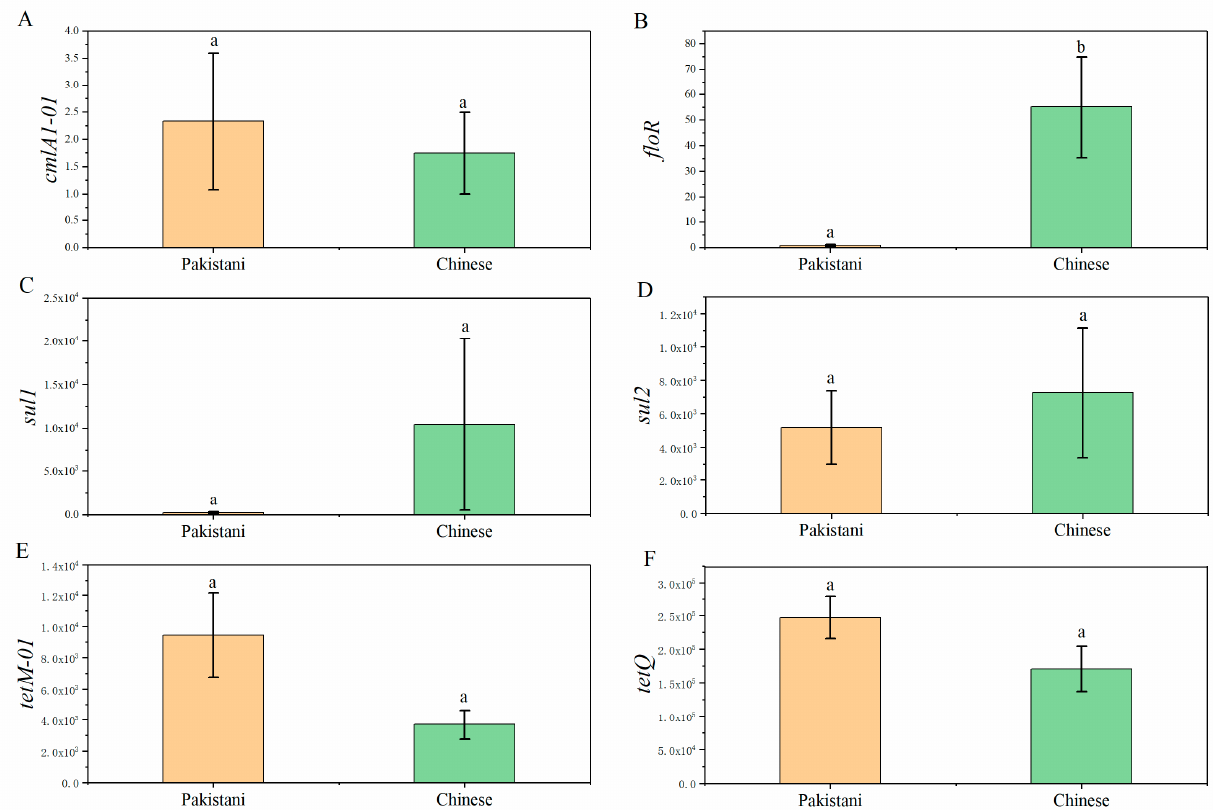
Figure 6. The comparison of ARGs using Mann–Whitney U test between Chinese and Pakistani. The mark of (a) and (b) indicated a significant difference between two groups ( p < 0.05). ( A ): Comparison of cmlA1-01 ; ( B ): Comparison of floR; ( C ): Comparison of sul1 ; ( D ): Comparison of sul2 ; ( E ): Comparison of tetM-01 ; ( F ): Comparison of tetQ .